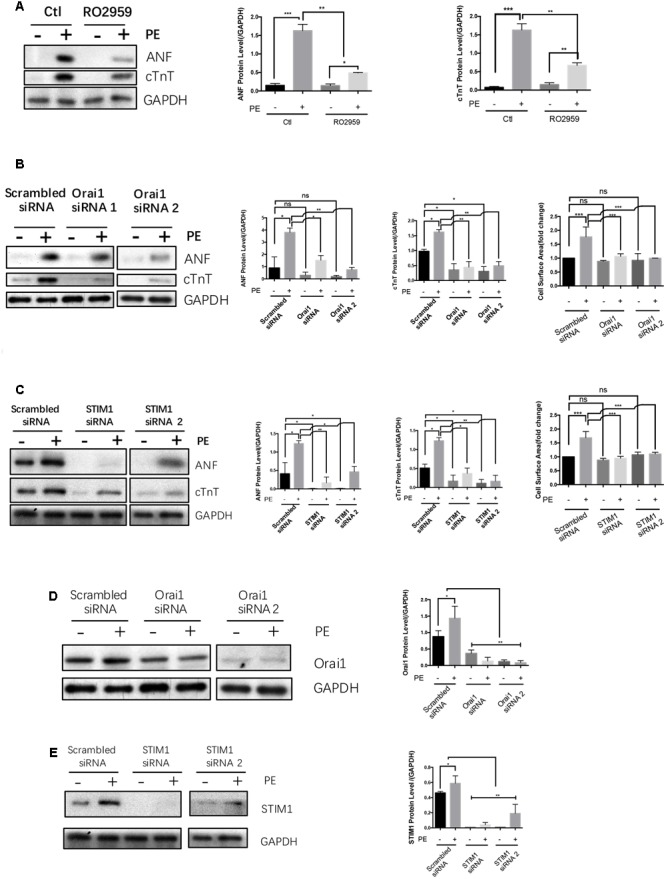
SOCE/STIM1/Orai1 were linked to hypertrophy in NRCMs. NRCMs were treated with 5 μmol/L RO2959, or transfected with Orai1-siRNA, STIM1-siRNA or Scrambled-siRNA, followed by 50 μmol/L PE for 48 h to induce hypertrophy. Negative control group (–) did not undergo PE treatment. (A) Effects of RO2959 on PE-induced cardiomyocyte hypertrophy. (B,C) Effects of Orai1-siRNAs and STIM1-siRNAs on PE-induced cardiomyocyte hypertrophy. The hypertrophy was assessed by protein expression of ANF and cTnT (A–C) as well as cell surface area (B,C). (D,E) Effectiveness of Orai1-siRNAs and STIM1-siRNAs in suppressing the protein expression of their respective targets. Shown were representative Western blot images (left) and data summary (right). The data are expressed as the mean ± SEM (n = 5). ∗p < 0.05; ∗∗p < 0.01; ∗∗∗p < 0.001. ns, not significant.